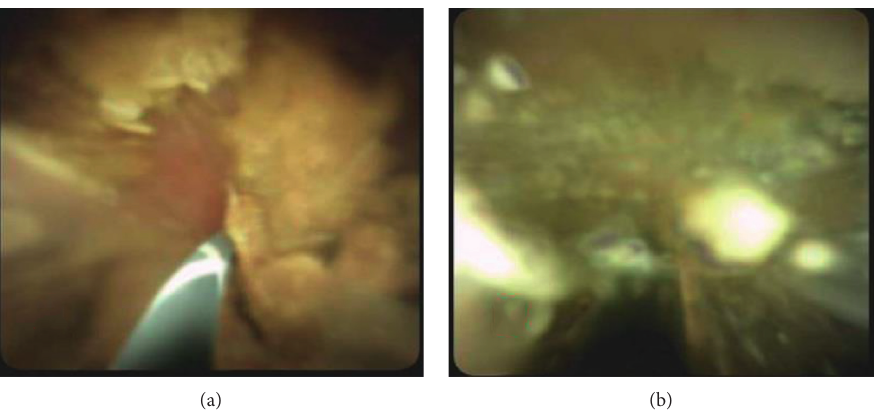
Figure 7: (a) Cholangioscopy showing CBD stones and (b) EHL resulting in common bile duct stone fragmentation.